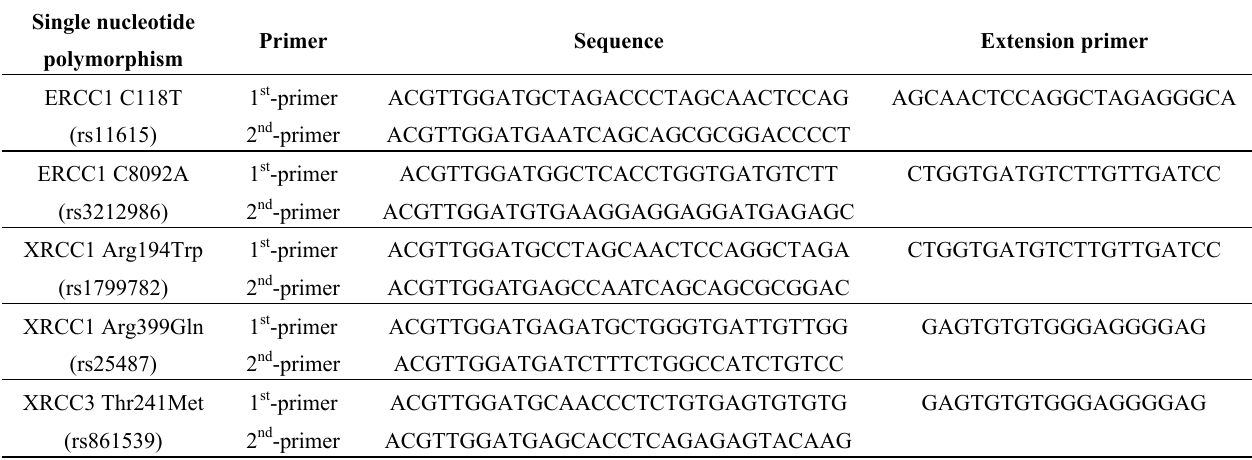
Table 5. PCR primers of selected